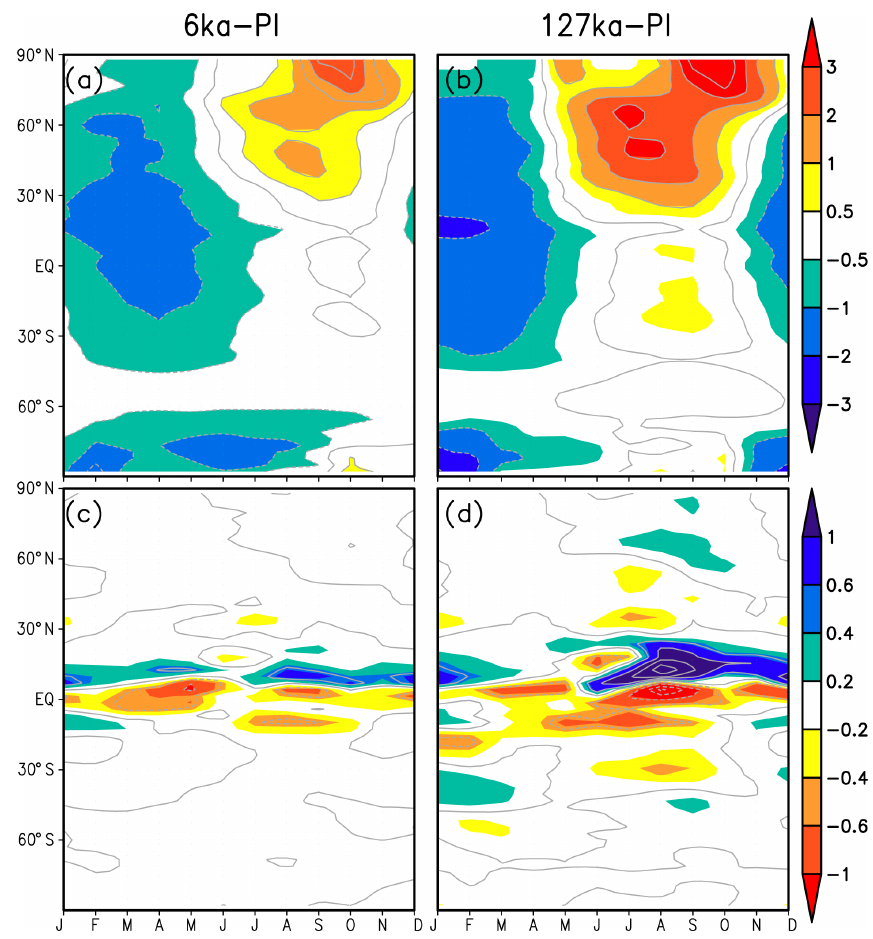
Figure 12. Hovmöller diagrams for (a) air temperature anomaly at 2m height ( ◦ C) for 6ka relative to PI, (b) air temperature anomaly at 2m height ( ◦ C) for 127ka relative to PI, (c) precipitation anomaly (mmd − 1 ) for 6ka relative to PI, and (d) precipitation anomaly (mmd − 1 ) for 127ka relative to PI. Calendar adjustments are